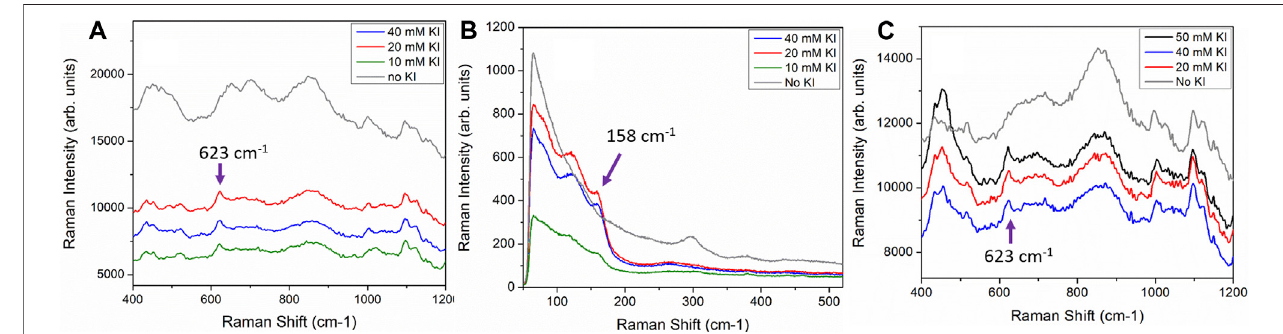
FIGURE 1 | Printed sensors functionalized with 50 mM, 40 mM, 20 mM and 10 mM KI solution for 30 min followed by exposure to a 100 μ g/ml heroin solution for 30 min (A) SERSspectraacquiredwithhandheldRamananalyzershowingclearheroinpeakat623 cm − 1 . (B) LowerwavenumberbandsofthesensorsshowninAwith theiodidefunctionalizedsensorsexhibitAu-Ibandat 158 cm − 1 .SERS spectraacquired withHoribaLabRAM HRmicroRamanspectrometer. (C) .Printedsensorswere functionalized with50 mM, 40and 20 mMKI solutionsfor 90 sfollowed by90 sofexposuretoa100 μ g/ml heroin solution.SERS spectraacquired withhandheld Raman analyzer. Control sensors with no exposure to KI prior to heroin immersion are shown as grey spectra in each